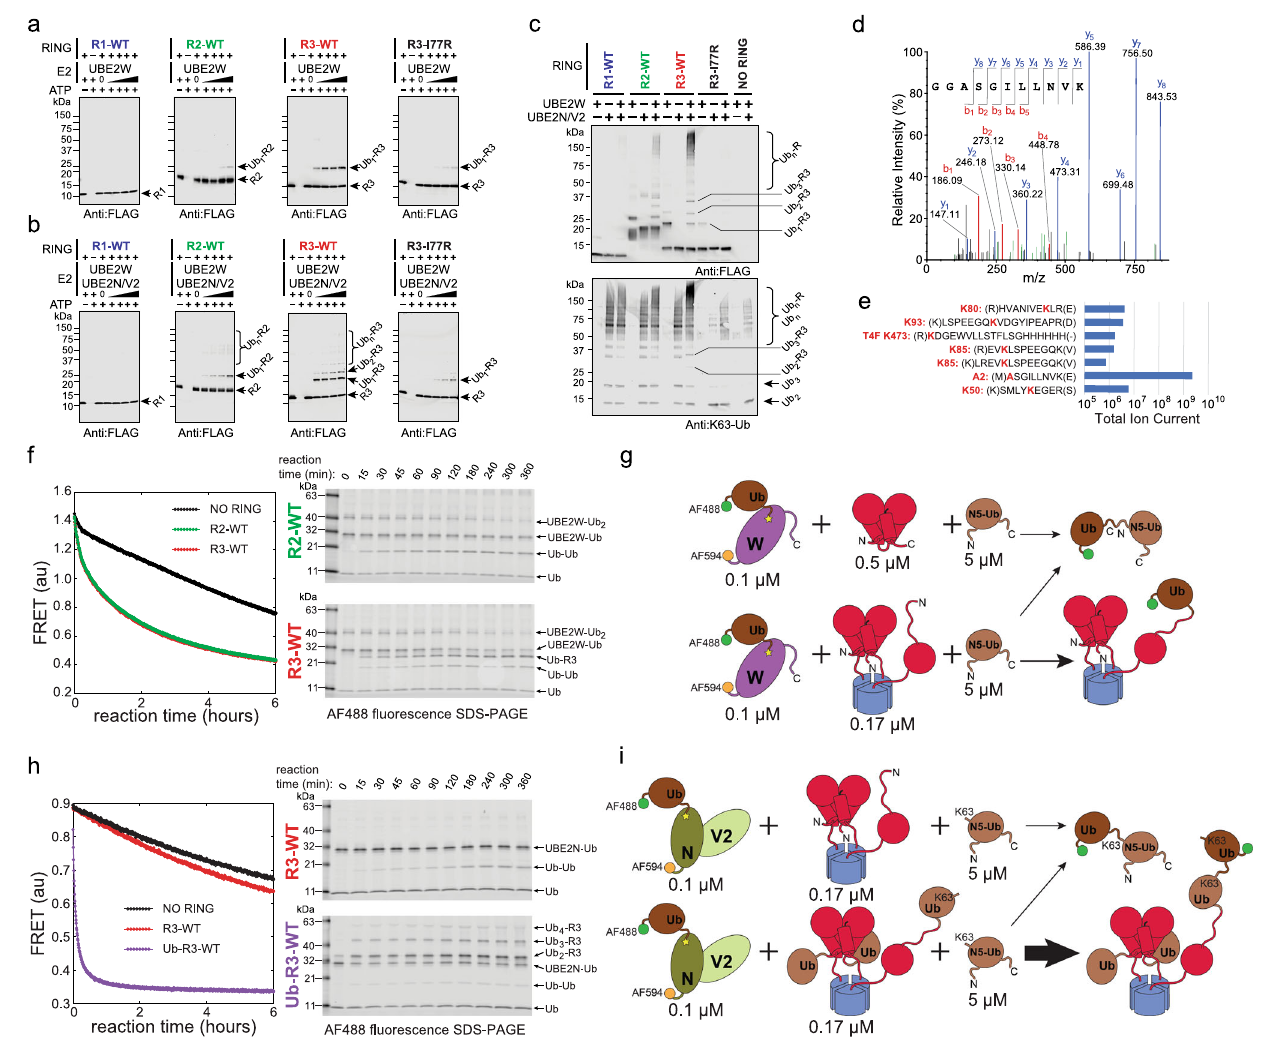
Fig. 4 | Proximity of three RING domains promotes each of the two distinct stepsintheautoubiquitylationofTRIM5 α :theN-terminalmonoubiquitylation (priming)andtheextensionoftheTRIM5 α -anchoredK63-linkedpolyubiquitin chain. a , b RING autoubiquitylation products visualized by WB of FLAG-tagged RING constructs. [RING]=5 µ M, [Ub]=10 µ M, [E2]=0.1; 0.2; 0.5; 1 µ M. 30min incubation. a Monoubiquitylation of RING in the presence of the increasing amountsof UBE2W. b RINGpolyubiquitylationinthe presenceof bothUBE2Wand the heterodimeric UBE2N/V2. c Ubiquitylation products of different E2/E3 combi- nations analyzed side-by-side on the same SDS-PAGE gel. [RING]=5 µ M, [Ub] = 10 µ M, [E2]=1 µ M. 30min incubation. WB was performed with either anti-FLAG antibodies (top panel) or anti-K63-linked-Ub antibodies (bottom panel).